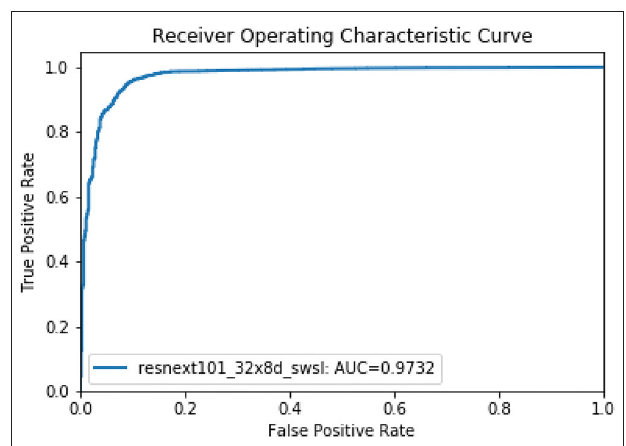
FIGURE 4 | The ROC curve of the second model stage for discriminating countable and uncountable